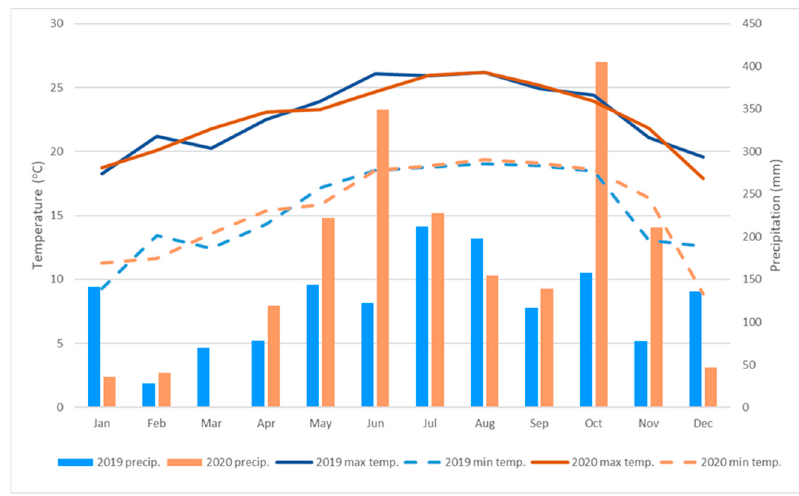
Figure 1. Precipitation, maximum, and minimum temperatures for 2019 and 2020. Fort Pierce, FL, USA. (Source: FLORIDA CLIMATE CENTER, 2021).